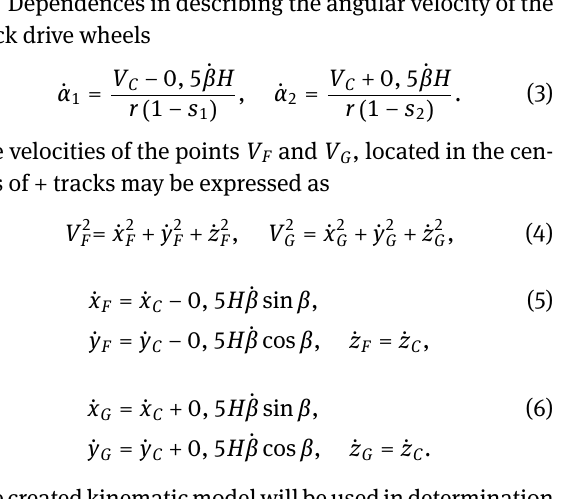
Figure 2: Photo of the robot prototype during underwater Fig. 2. Photo of the robot prototype during underwater tests